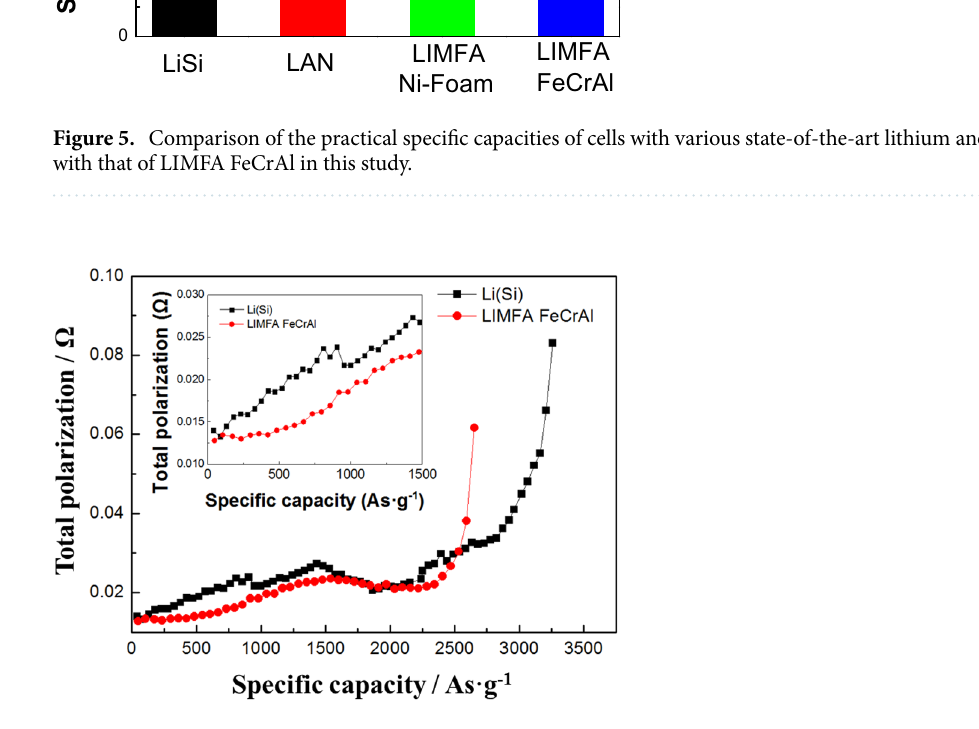
Figure 6. Total polarization curves of Li(Si) and LIMFA FeCrAl obtained from the cell discharge test